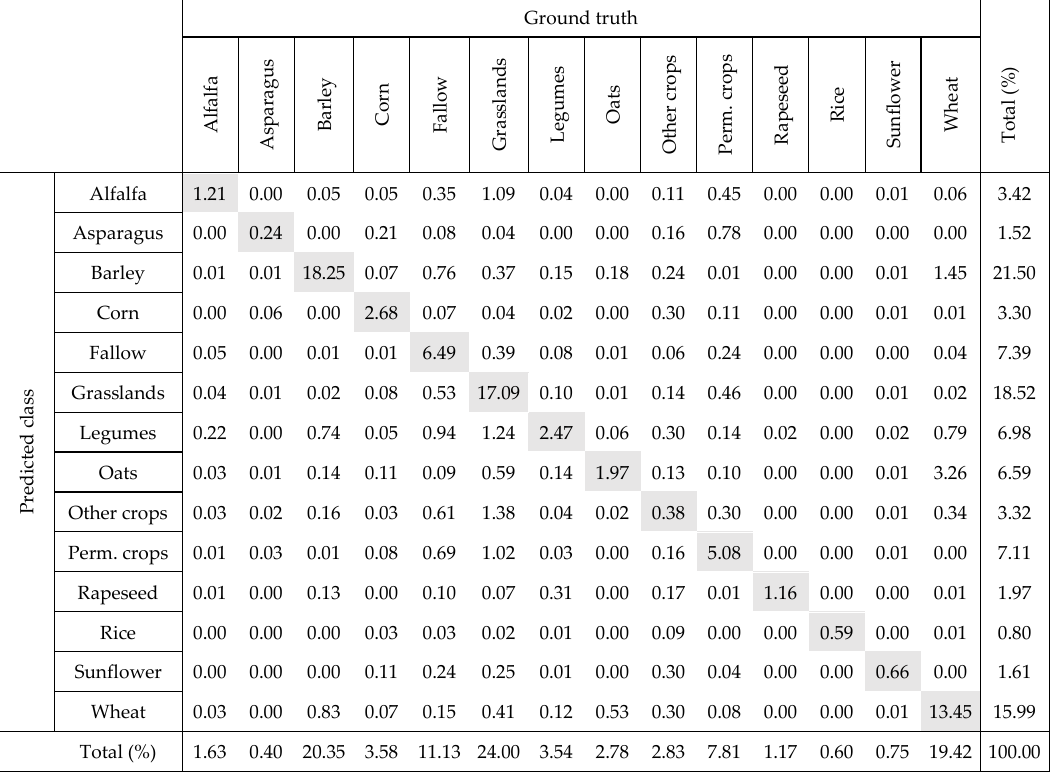
Table 7. Confusion matrix of Ens scheme in Navarre (using R 2 as the best fit metric). Values are given as a percentage of the total number of fields